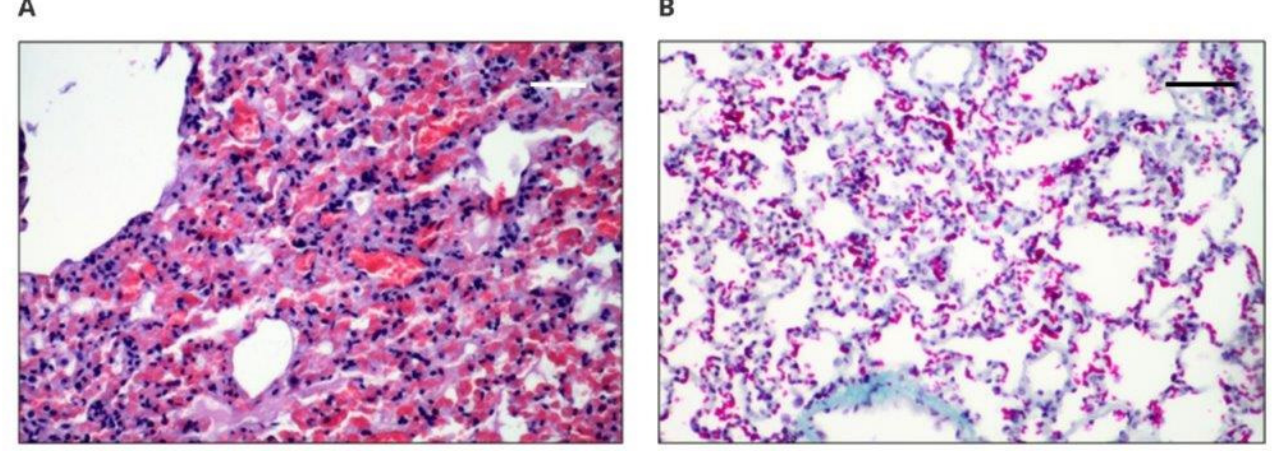
Figure 6. Microscopically assessed image of lungs collected from animals with implants: ( A ) 100× magnification (scale bar 100 µm), hematoxylin–eosin staining; ( B ), 50× magnification (scale bar 200 µm), Masson’s staining.